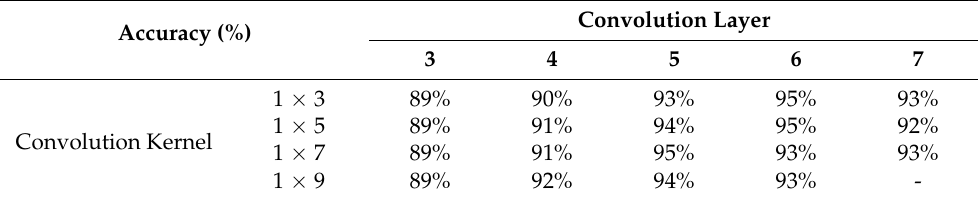
Table 1. Classification accuracies with different CNN